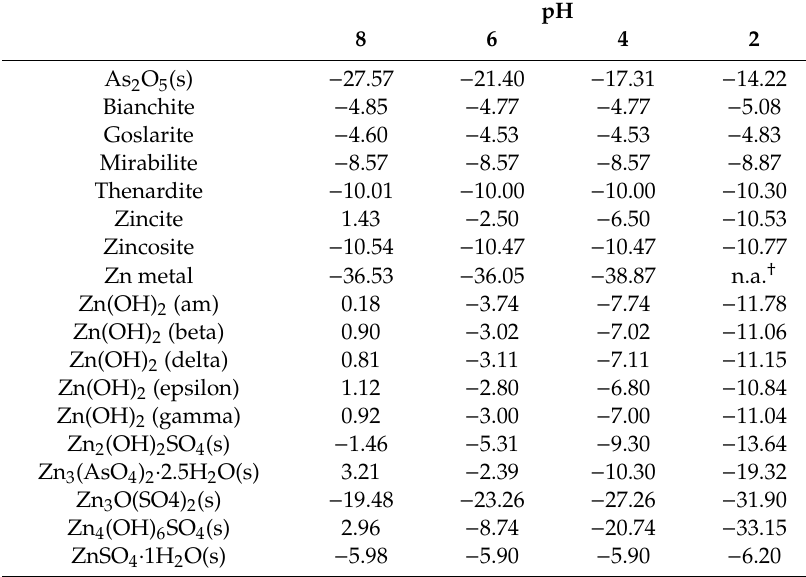
Table 1. Saturation index of As and Zn calculated via Visual MINTEQ 3.1 according to solution